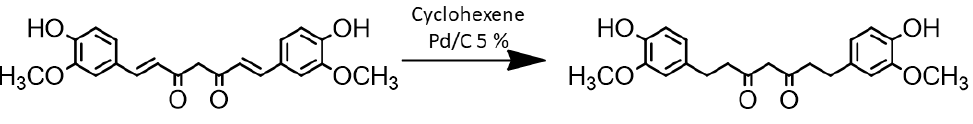
Figure 3. CM reduction process to obtain THCM.